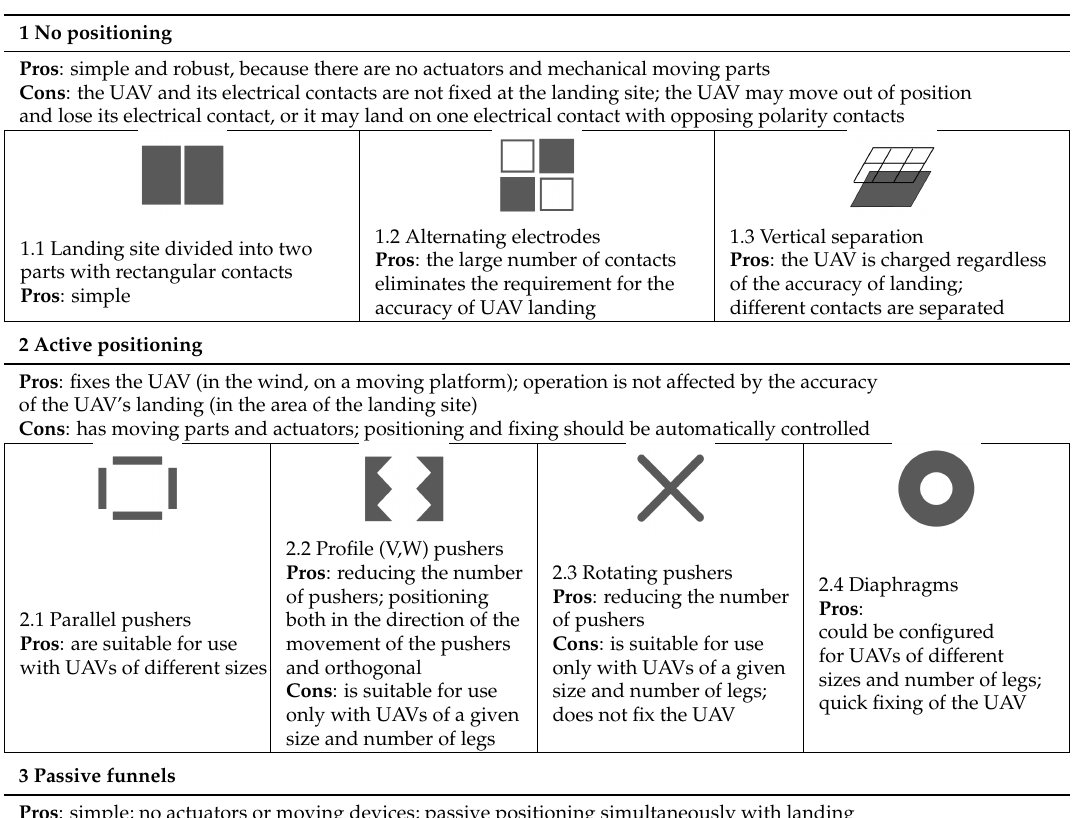
Table 1. Main positioning device types in UAV landing platforms at a